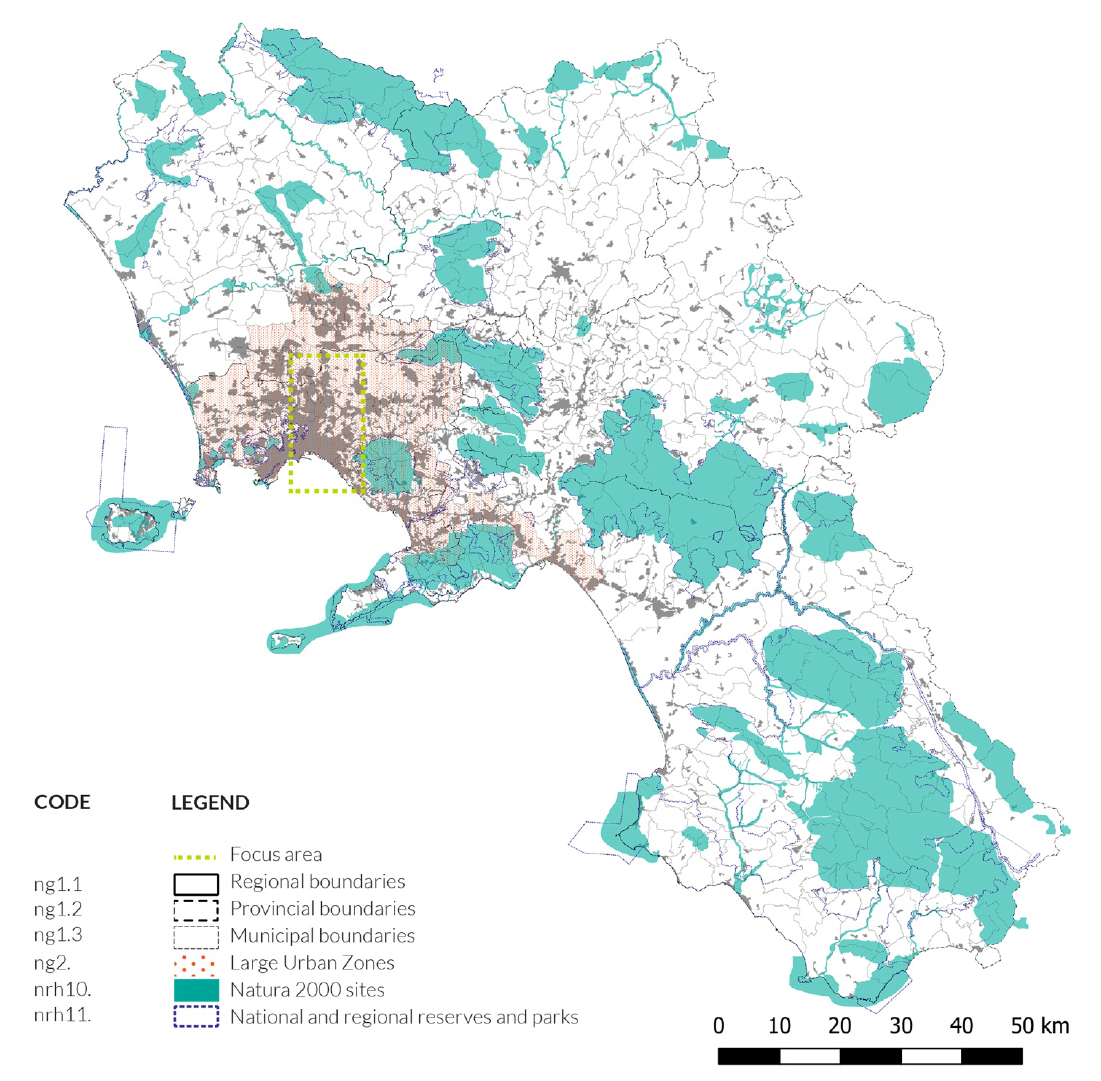
Figure 2. Administrative, demographic and planning issues. Pilot case of Naples. Source: REPAiR (2018c); map by REPAiR UNINA